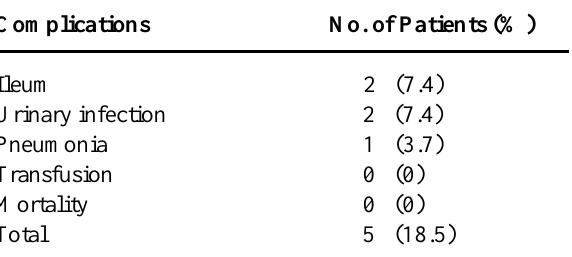
Table 2 – Postoperative complications in renal donors submitted to hand-assisted laparoscopic nephrectomy.